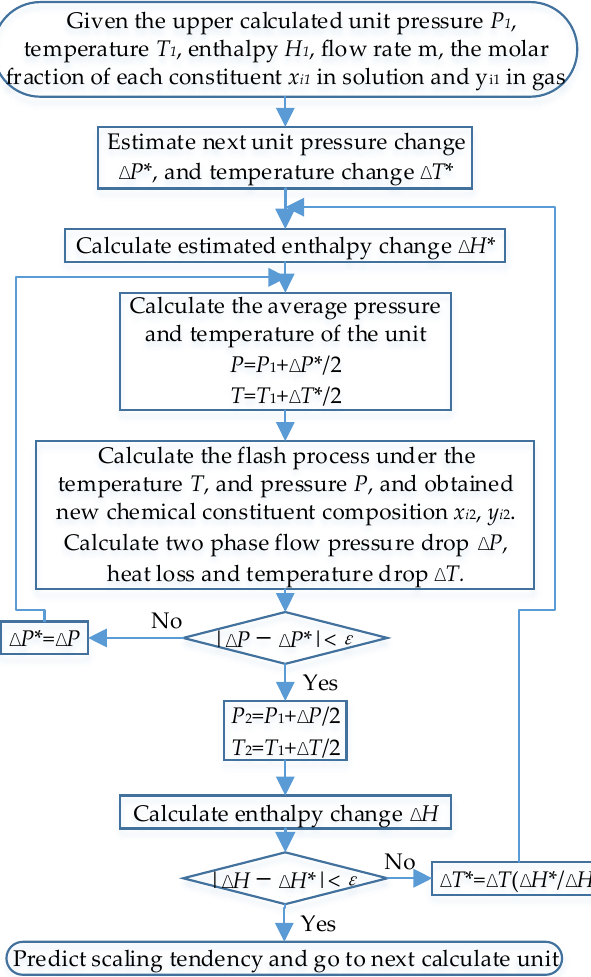
Figure 2. Flow chart of a calculation unit.